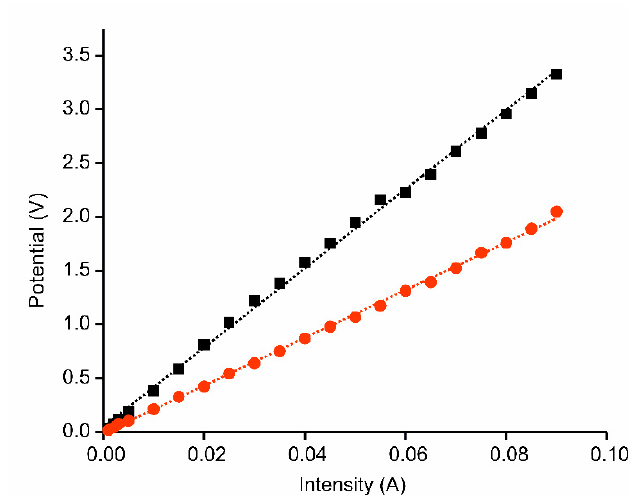
Figure 2. Intensity vs. potential regression curves of indium tin oxide (ITO) (black) and ITO- AgNWs